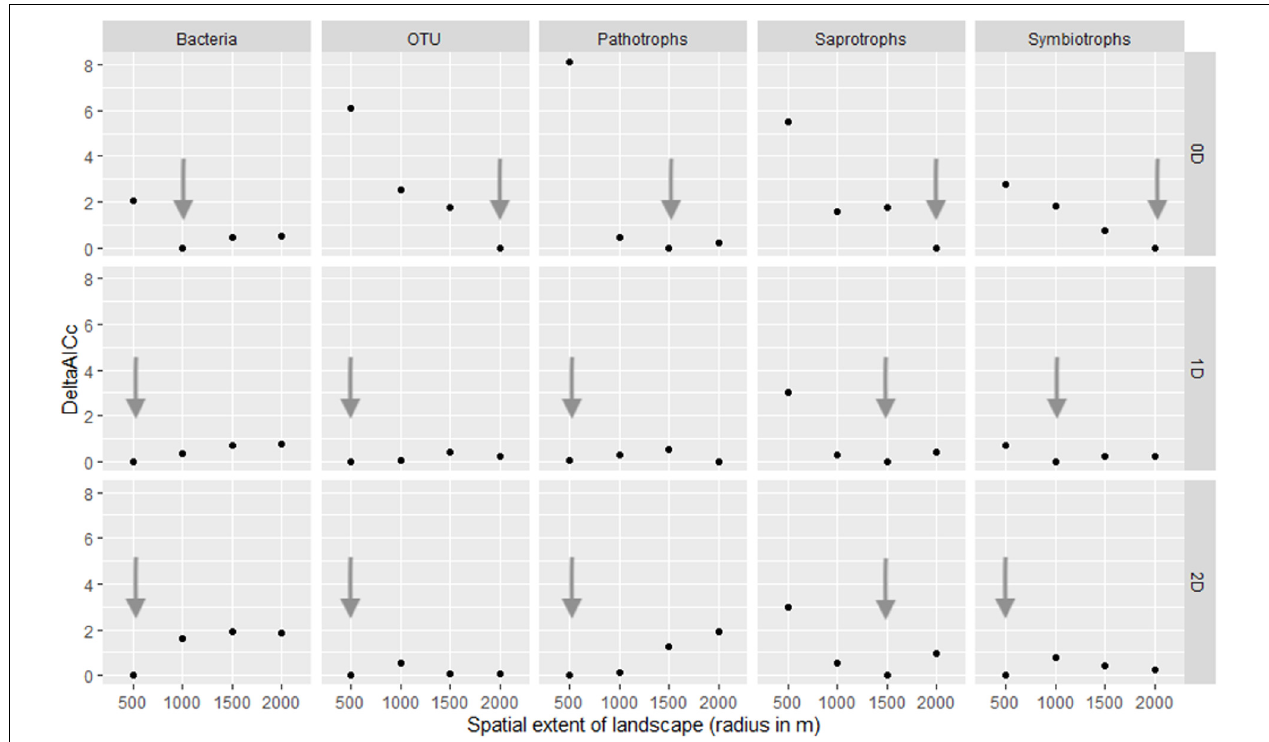
FIGURE 3 | Estimation of the scale of effect of the landscape variable (habitat amount) for each group and each Hill number ( 0 D: species richness, 1 D: Shannon index and 2 D: inverse of Simpson index). Arrows indicate the distance with the lower AIC and therefore the best model. OTU refer to all fungi